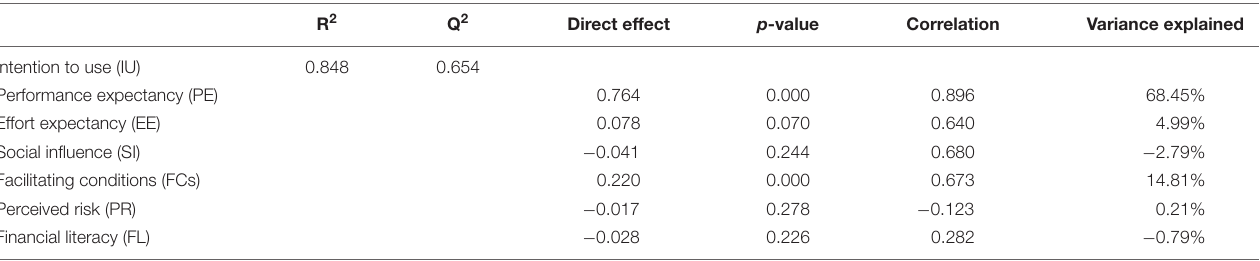
TABLE 6 | Partial least square predict assessment.